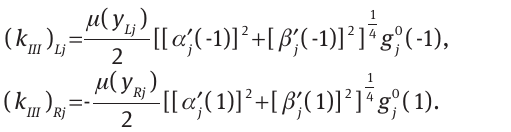
obtaining the SIFs in the classical elasticity.